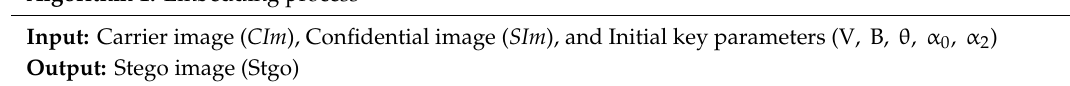
Algorithm 1: Embedding process